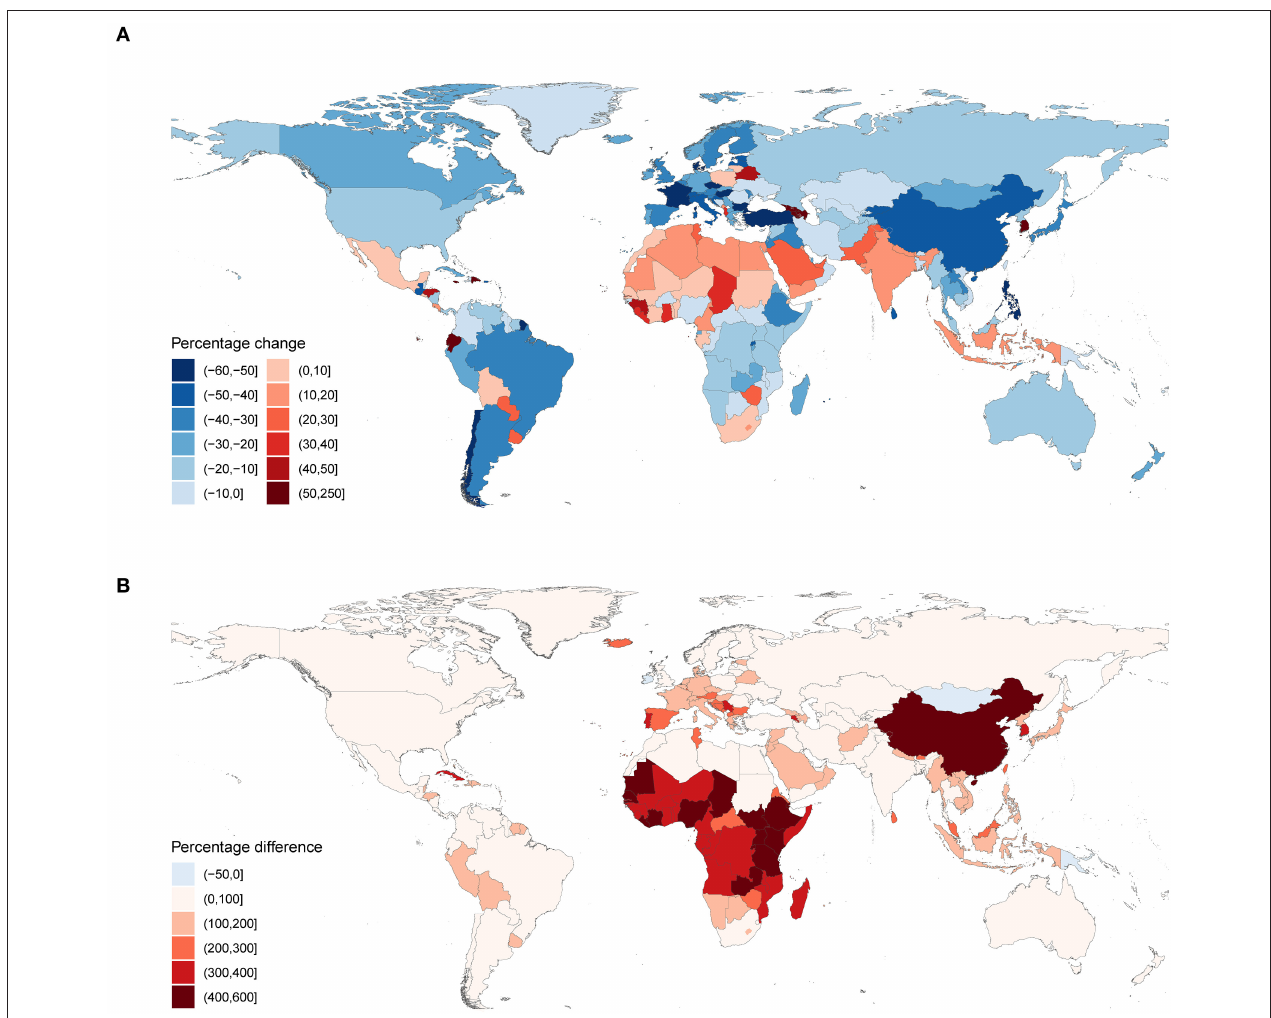
FIGURE 5 | Percentage changes and percentage differences of mortality rates from suicide. (A) Percentage changes in mortality rates from suicide for the elderly between 1990 and 2017; (B) percentage differences between mortality rates from suicide for the elderly and age-standardized mortality rates from suicide for all ages in 2017. In (B) , Percentage difference = 100 * (R elderly - R std ) / R std , where R elderly donates mortality rate from suicide for the elderly, and R std donates age-standardized mortality rate from suicide for all